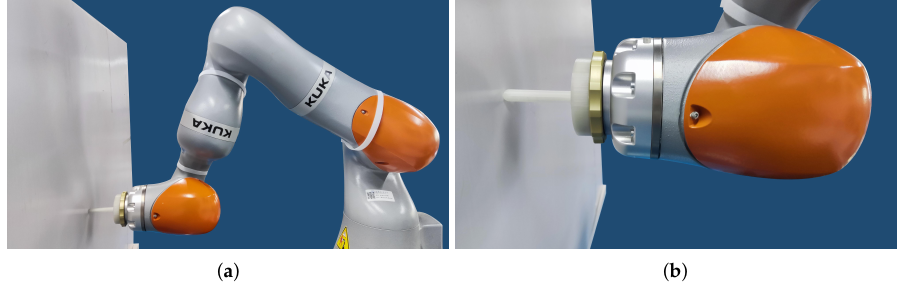
Figure 9. Different perspectives of the IIWA KUKA. The end effector needs to move up a cer- tain distance while remaining perpendicular to the wall. ( a ) The overall perspective. ( b ) The local